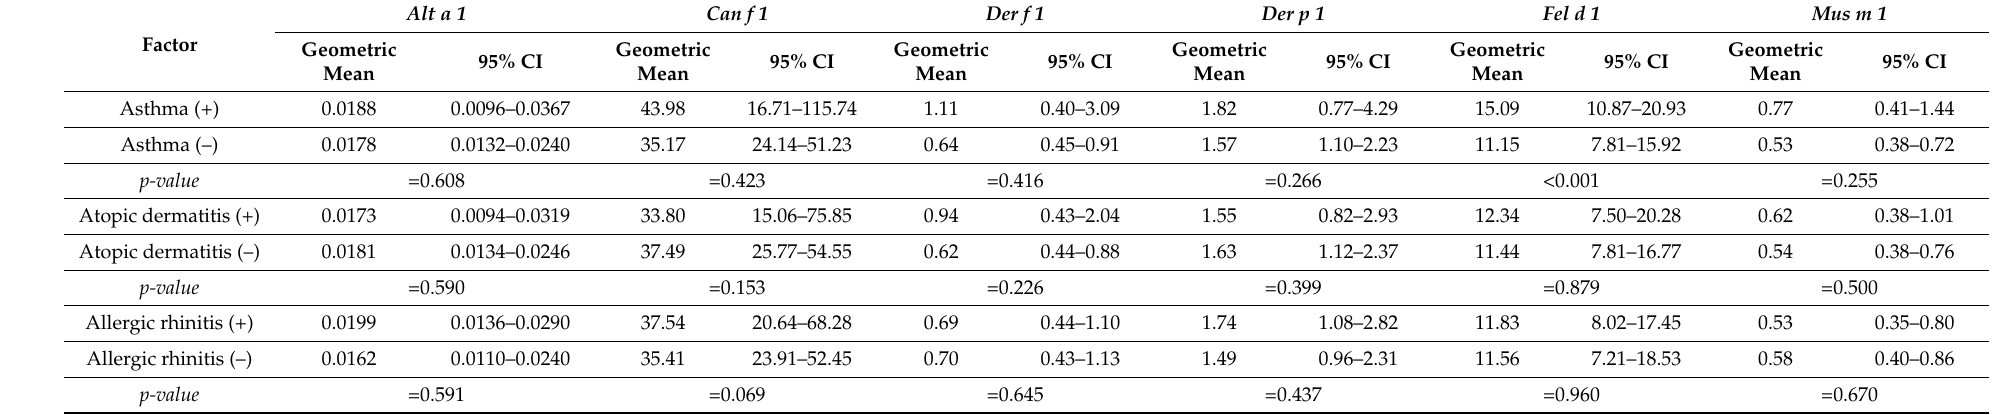
Table 4. Descriptive statistics for the concentrations of allergens in dust (ng/mL) in the studied children by selected health factors ( n =